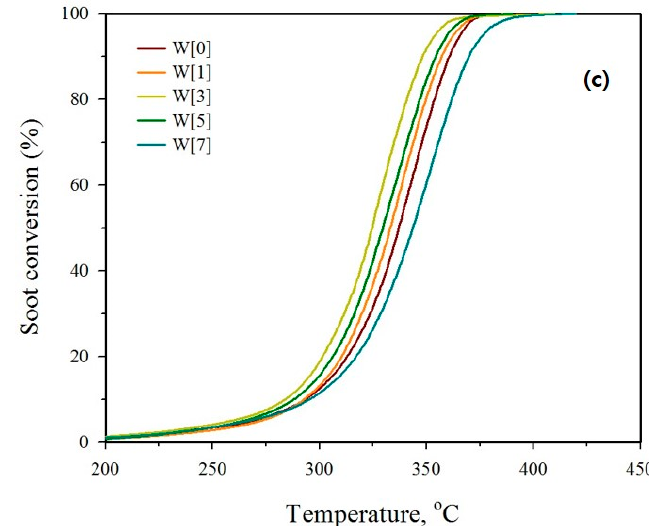
Figure 7. ( a ) NO 2 concentration profile during the NO oxidation reaction over Pt–W[x]/TiO 2 catalysts. Reaction conditions: catalyst = 100 g/L; reactant gas = 300 ppm NO, 3 ppm SO 2 , 10% O 2 , 5% H 2 O, and N 2 balance; flow = 1.0 L/min; GHSV = 50,000 h − 1 . ( b ) Soot oxidation performance of Pt–W[x]/TiO 2 catalysts using NO 2 . Reaction conditions: catalyst/soot = 8:2; reactant gas = 300 ppm NO 2 , 3 ppm SO 2 , 10% O 2 , 5% H 2 O, and N 2 balance; total flow = 0.1 L/min; GHSV = 50,000 h − 1 . ( c ) Soot oxidation performance of Pt–W[x]/TiO 2 catalysts using NO. Reaction conditions: catalyst/soot = 8:2; reactant gas = 300 ppm NO, 3 ppm SO 2 , 10% O 2 , 5% H 2 O, and N 2 balance; total flow = 0.1 L/min; GHSV = 50,000